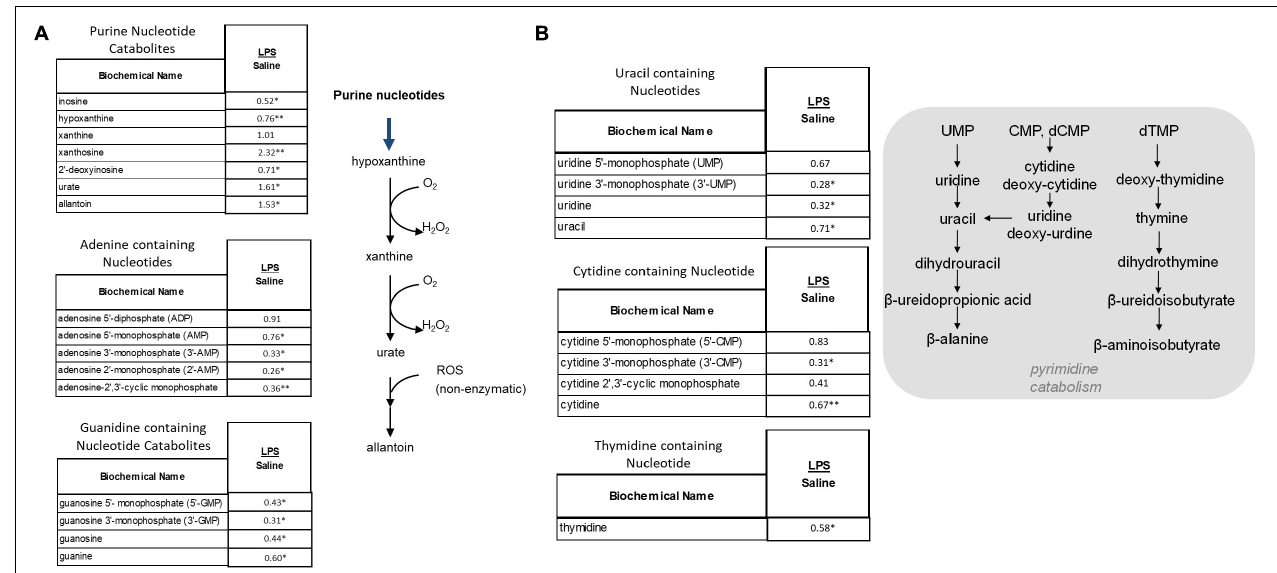
FIGURE 7 | Alterations in Purine (A) and Pyrimidine (B) Metabolism in LPS Placenta. Relative values of differentially expressed metabolites in LPS placenta expressed as fold change of controls. ∗ Significantly different between LPS and control placenta, p ≤ 0.05 and q ≤ 0.05. ∗∗ Significantly different between LPS and control placenta, p ≤ 0.05 and q ≤ 0.1. N = 8 both groups.